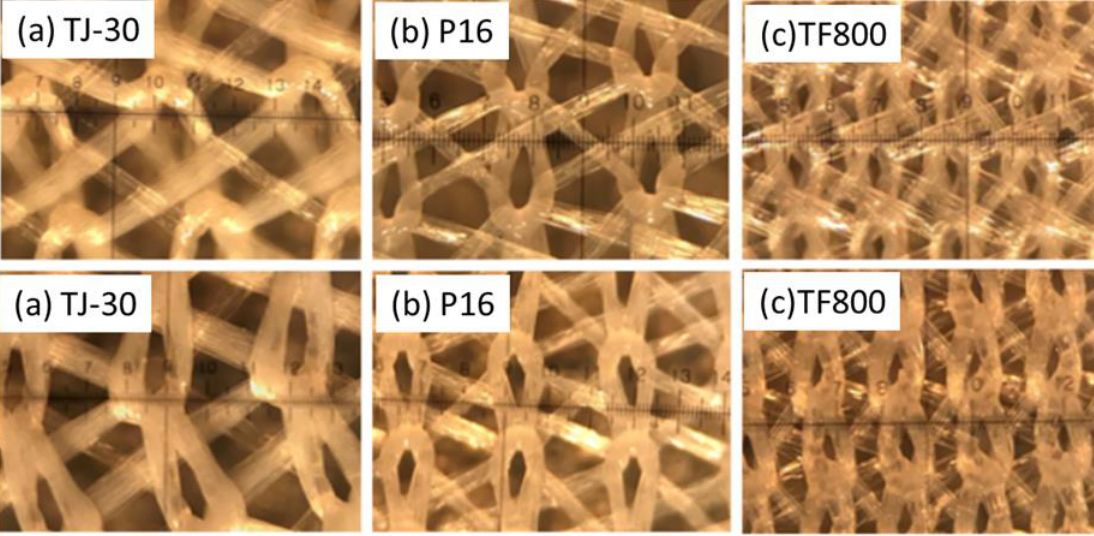
Figure 2. Optical microscope images of the reinforced materials used in this study: ( a ) TJ30 (pores ~400 μ m), ( b ) P16 (pores ~300 μ m), and ( c ) TF800 (pores ~100 μ m). (pores ~ 400 µ m), ( b ) P16 (pores ~ 300 µ m), and ( c ) TF800 (pores ~ 100 µ